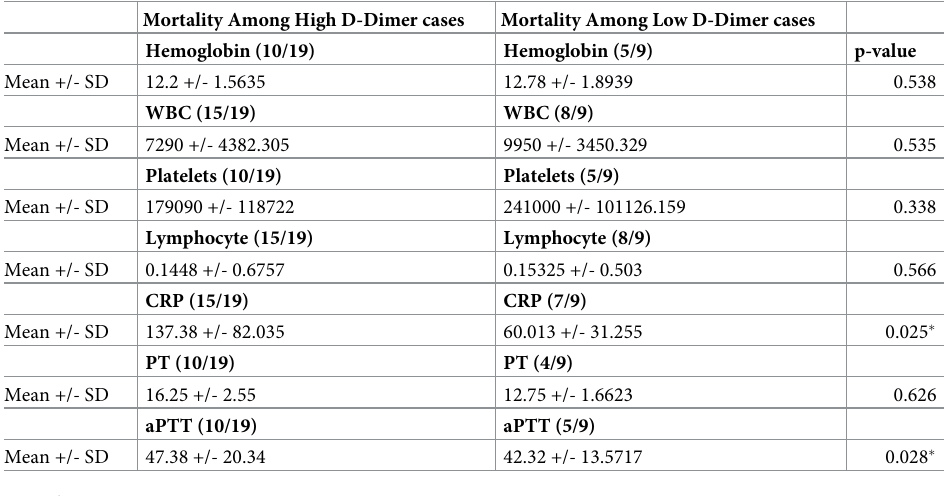
Table 4. Basic laboratory values among high and low D-dimer